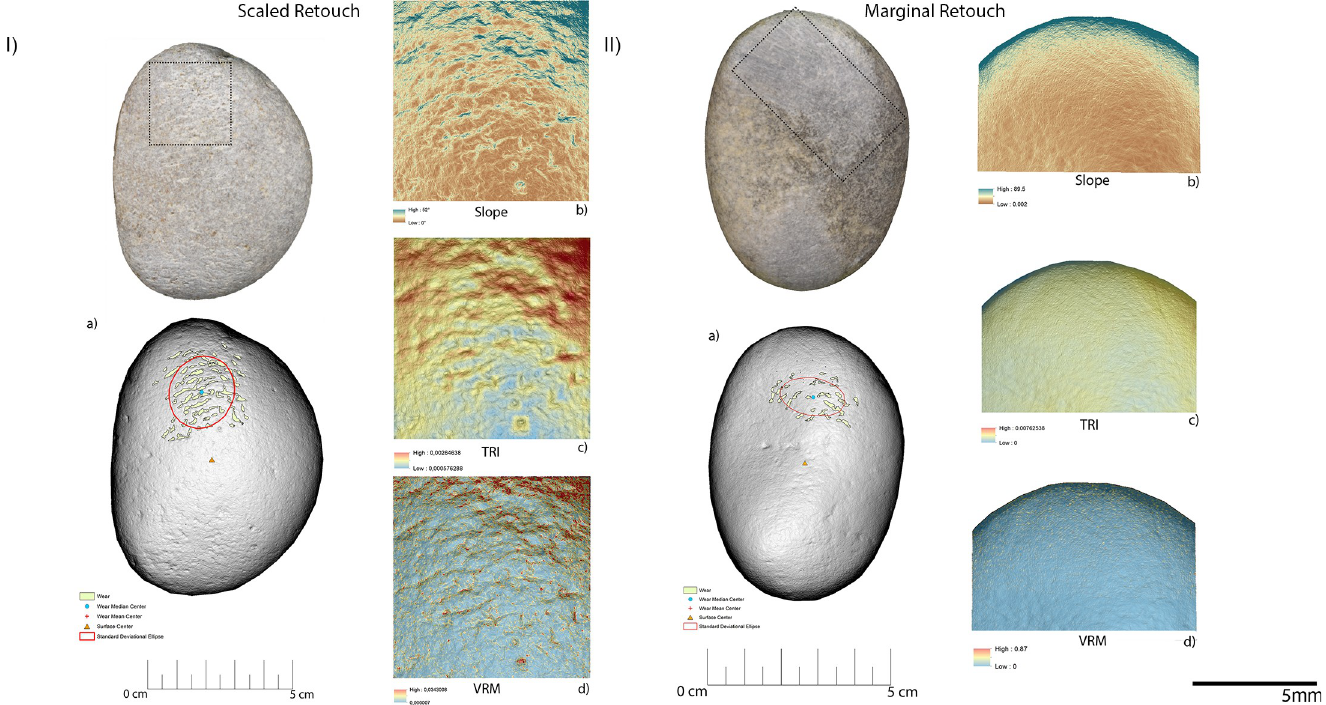
Fig 15. Experimental objects utilized for scaled retouch (I) and marginal retouch (II). (a) Spatial distribution of the identified wear; (b) slope; (c) terrain roughness index; (d) vector roughness